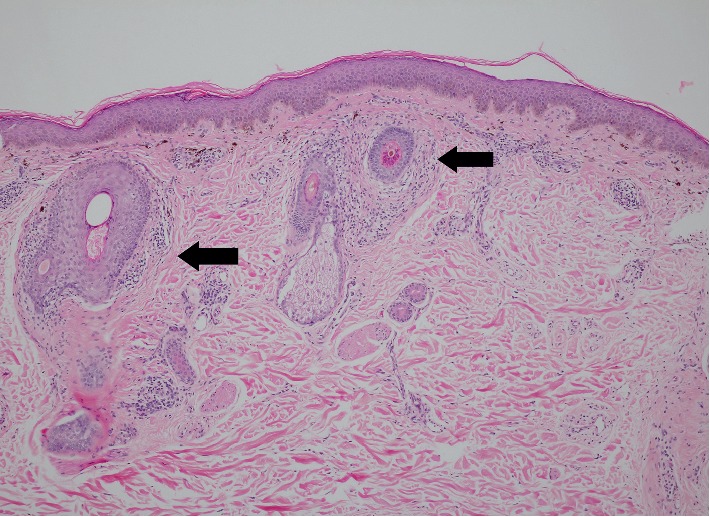
Perifollicular lymphocytic infiltration and fibrosis (arrow) in LPP (hematoxylin-eosin stain, original magnification ×100).